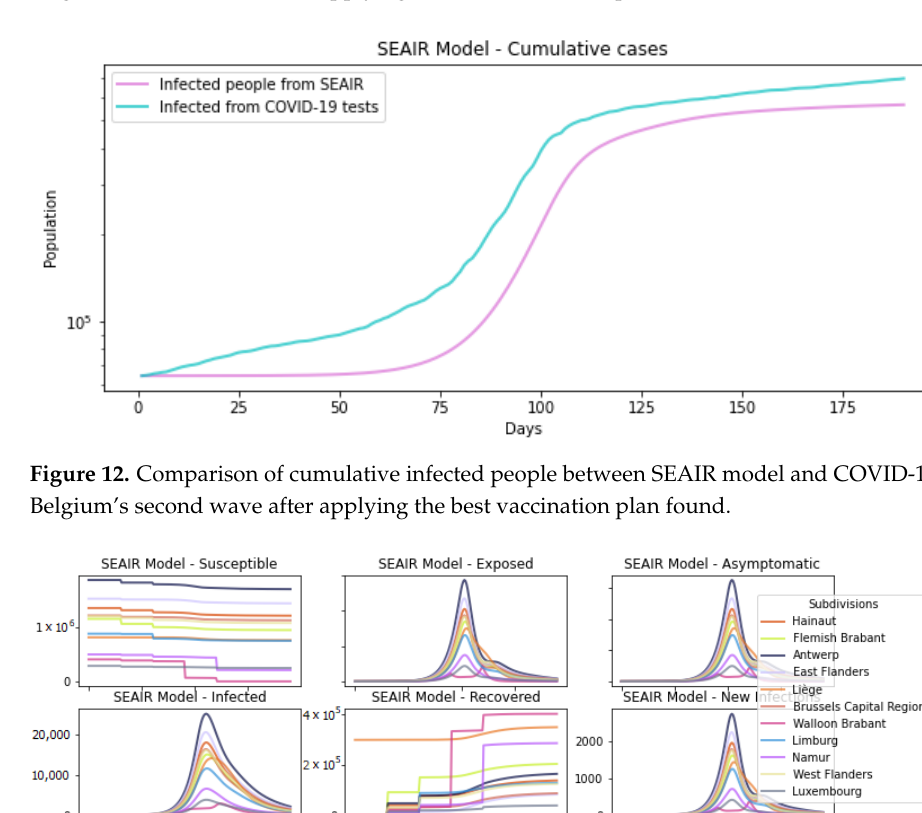
Figure 11. Comparison of cumulative infected people between SEAIR model and COVID-19 tests in Belgium’s second wave after applying the best vaccination plan found.